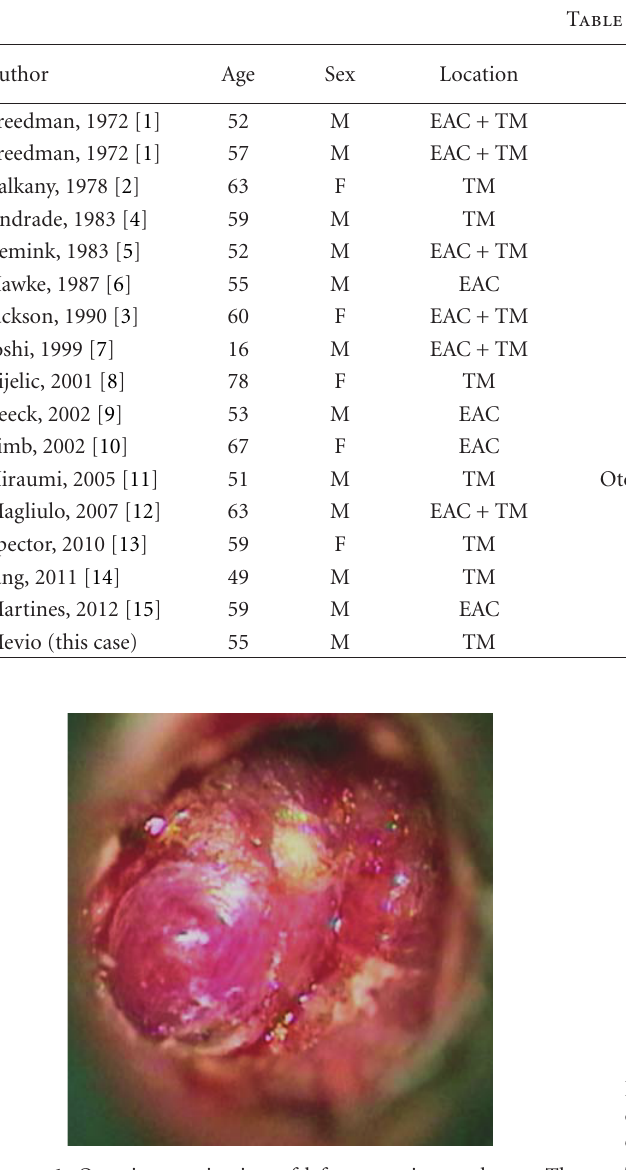
Figure 1: Otomicroscopic view of left tympanic membrane. The exofitic and vascular mass is seen in medial-superior part of the drum.